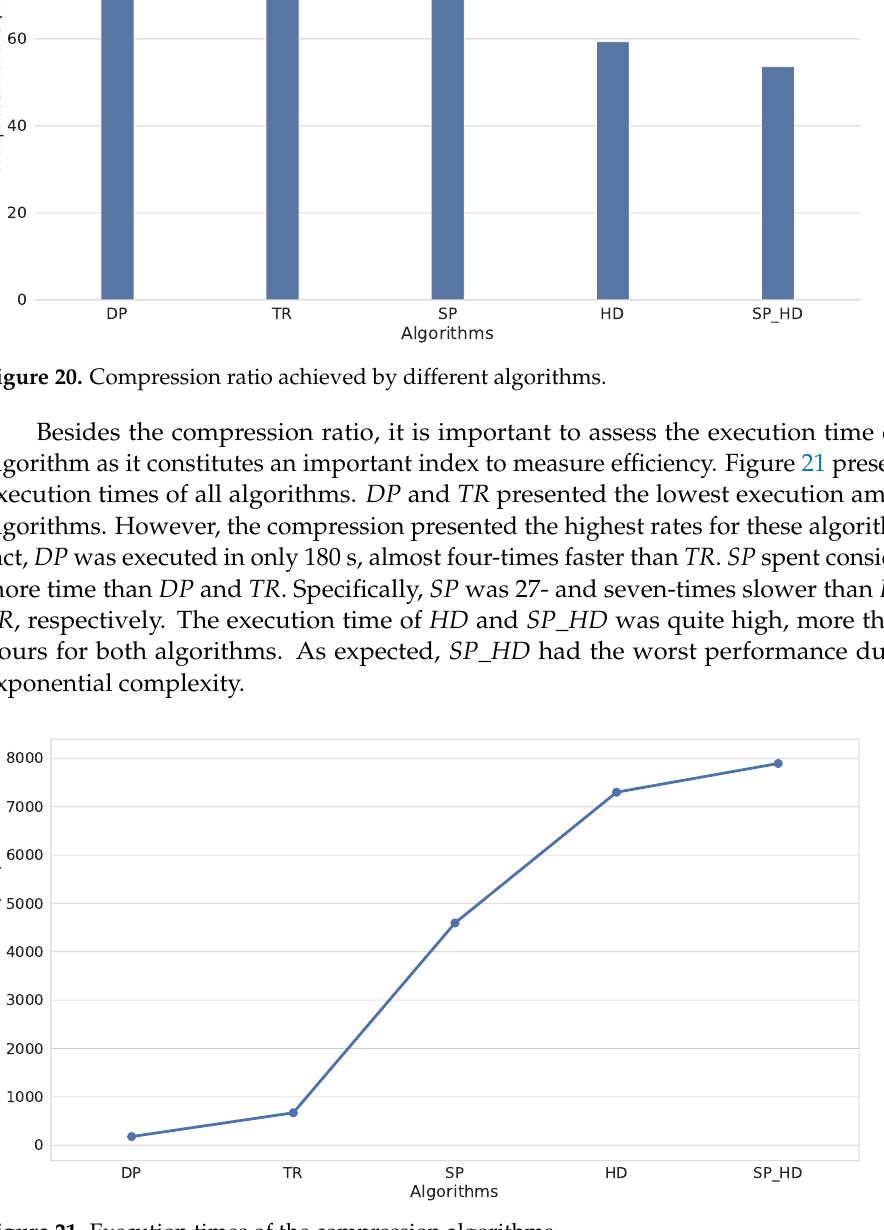
Figure 21. Execution times of the compression